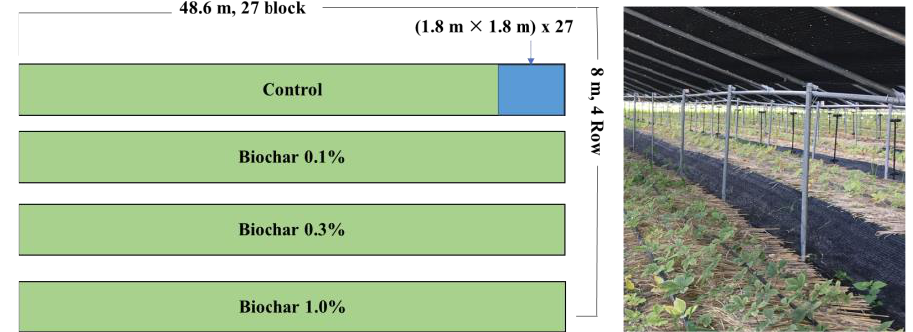
Figure 1. The coordinates of the experiment with view of the experimental site.